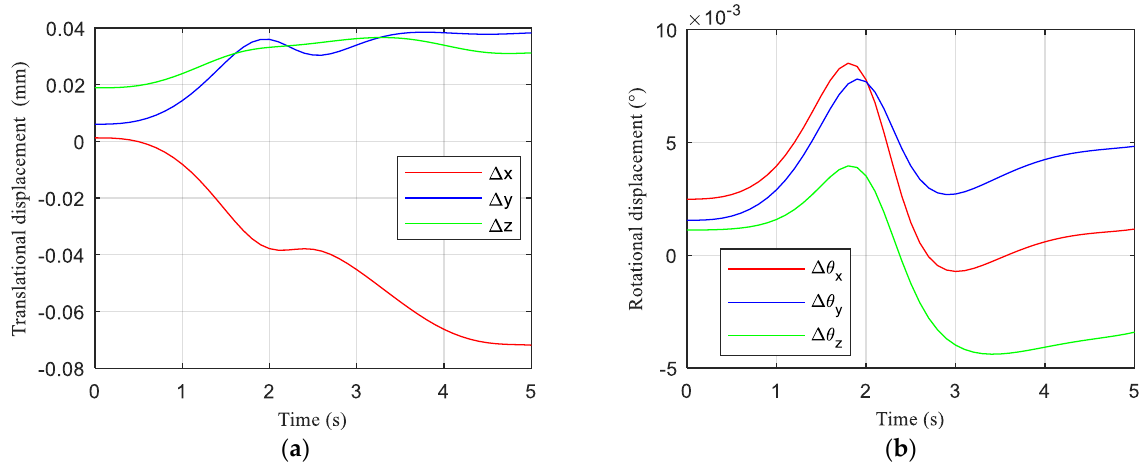
Figure 8. The generalized displacements of the end effector of the humanoid manipulator. ( a ) Real-time translational displacements of the end effector; ( b ) Real-time rotational displacements of the end effector.